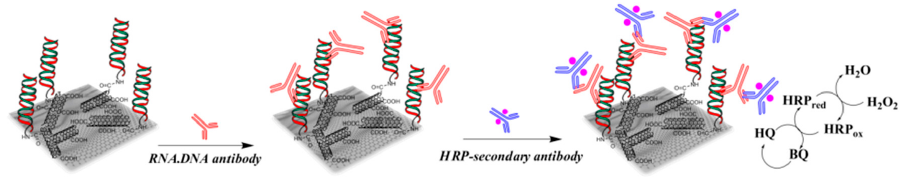
Figure 18. Electrochemical ELISA-like immunosensor for micro-RNA detection. Reprinted from [103], Copyright 2014, with permission from Elsevier.